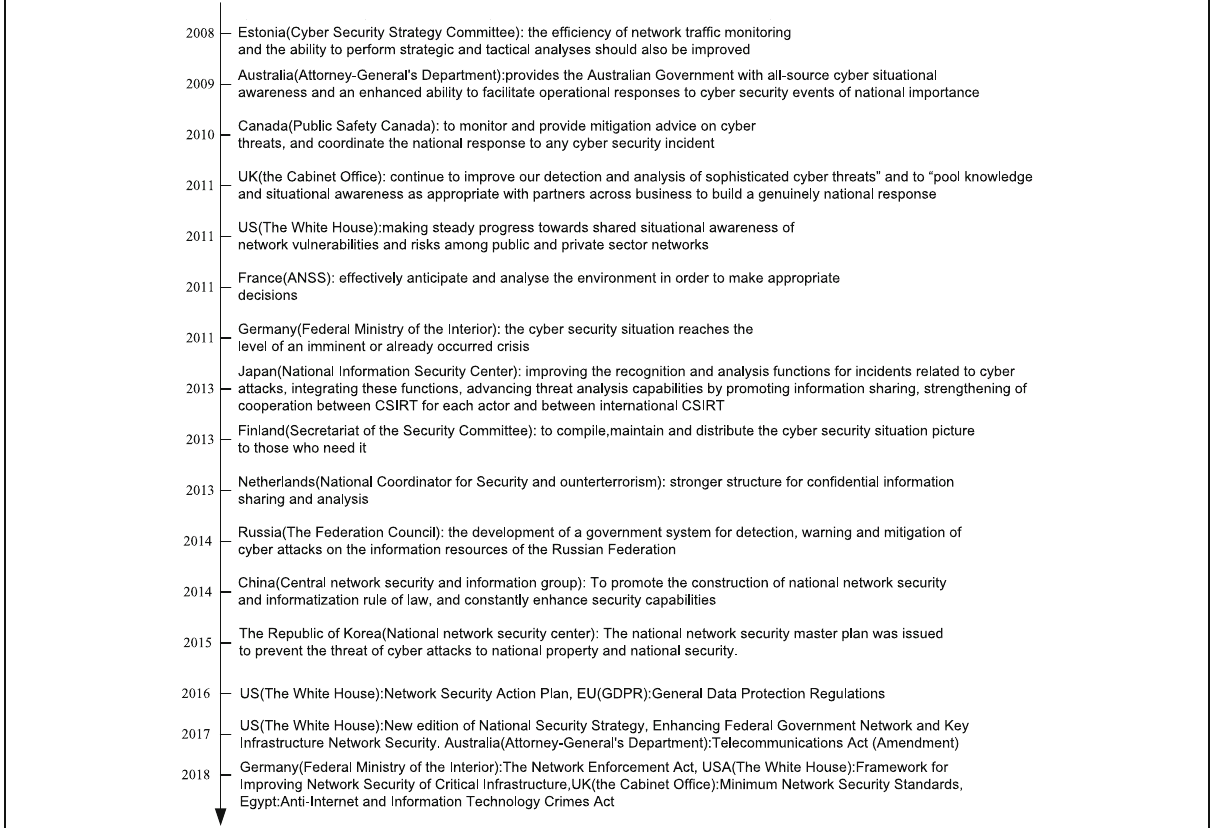
Fig. 1 Departments and public security strategies for network security in time series of